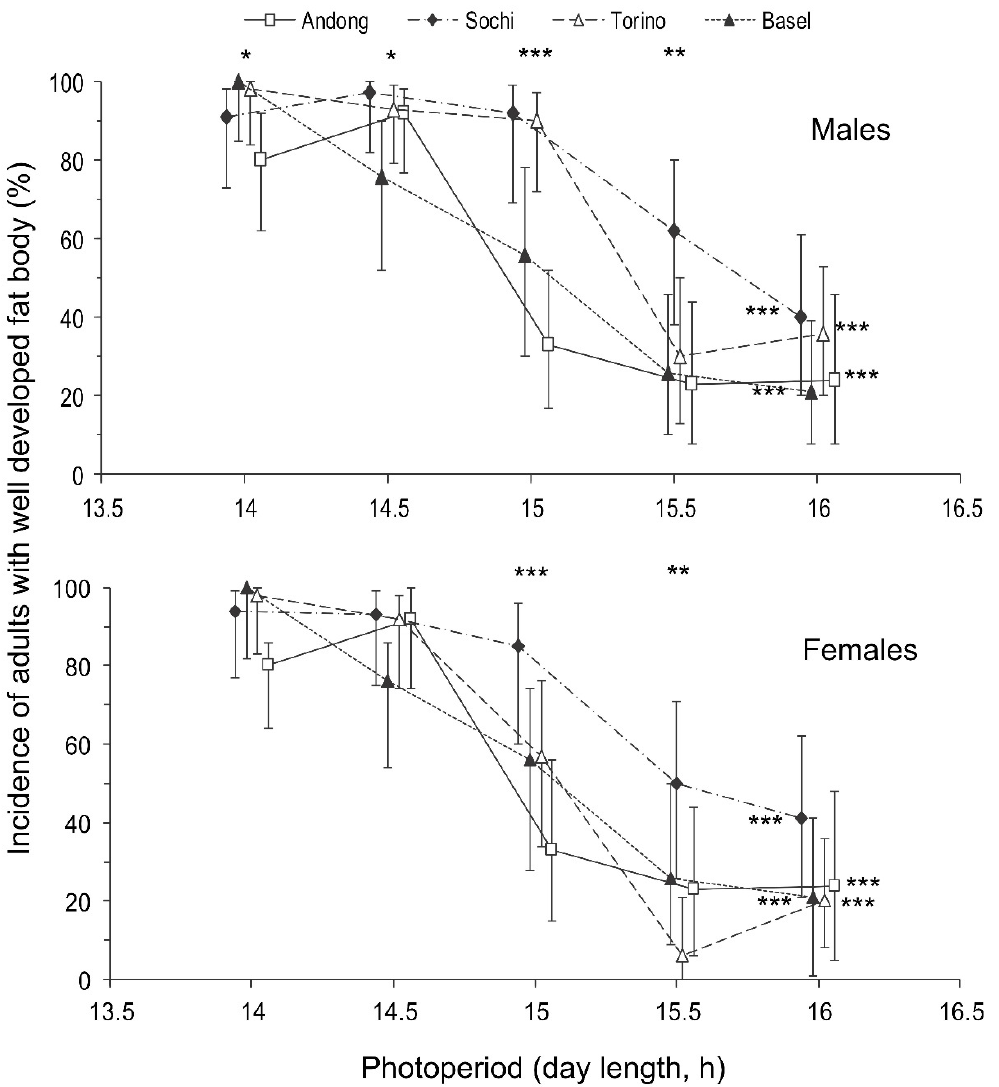
Figure 5. Effect of day length on the development of a fat body in Halyomorpha halys males and females from different populations at 24 °C. All other legends are as in Figure 4.